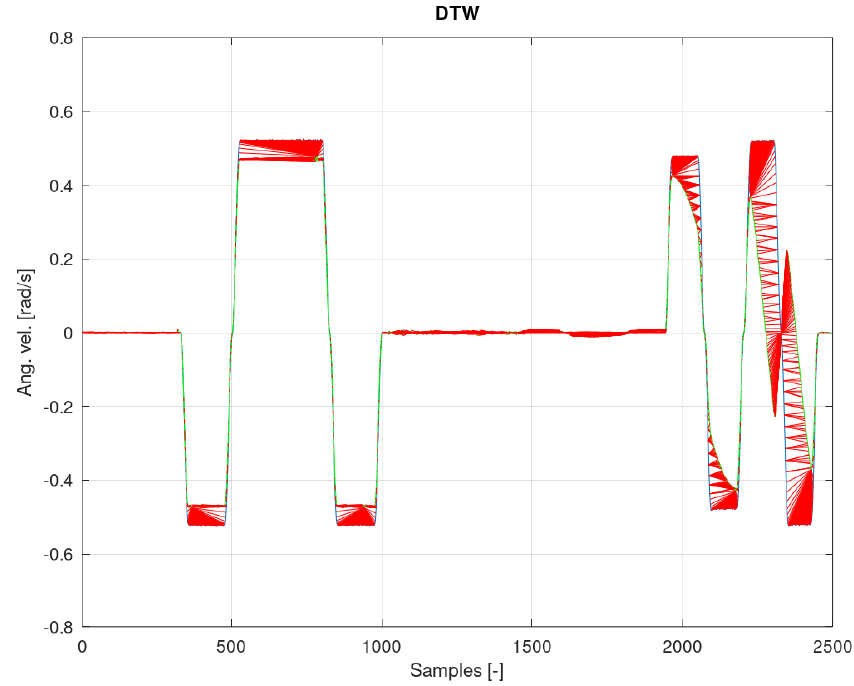
Figure 15. Analysis of the error from Figure 14 with the DTW algorithm.